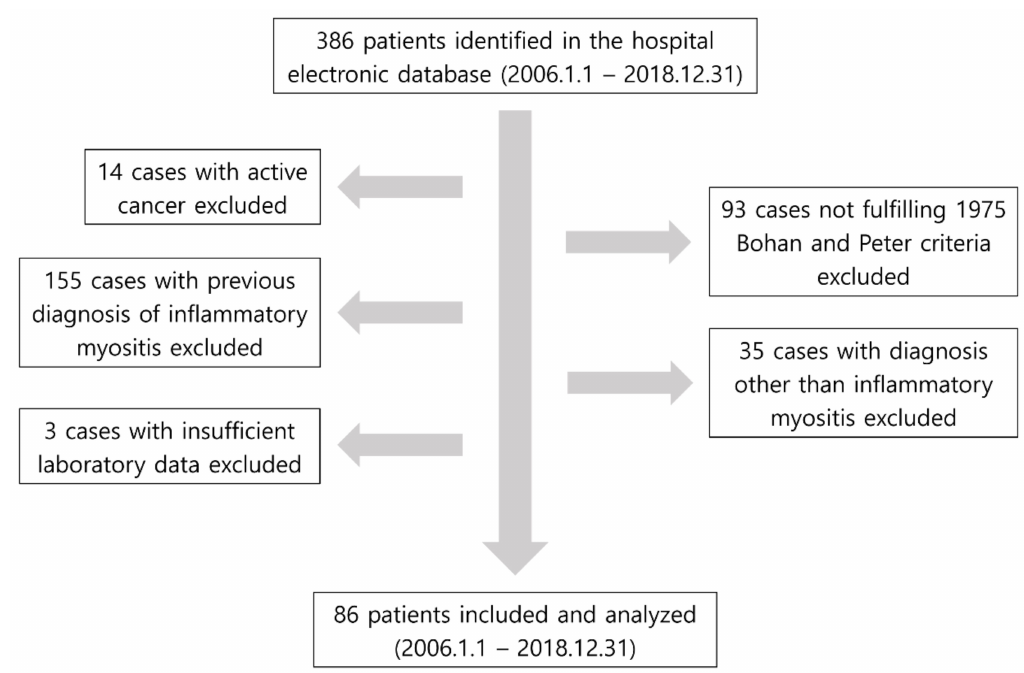
Figure 1. A schematic figure of patient